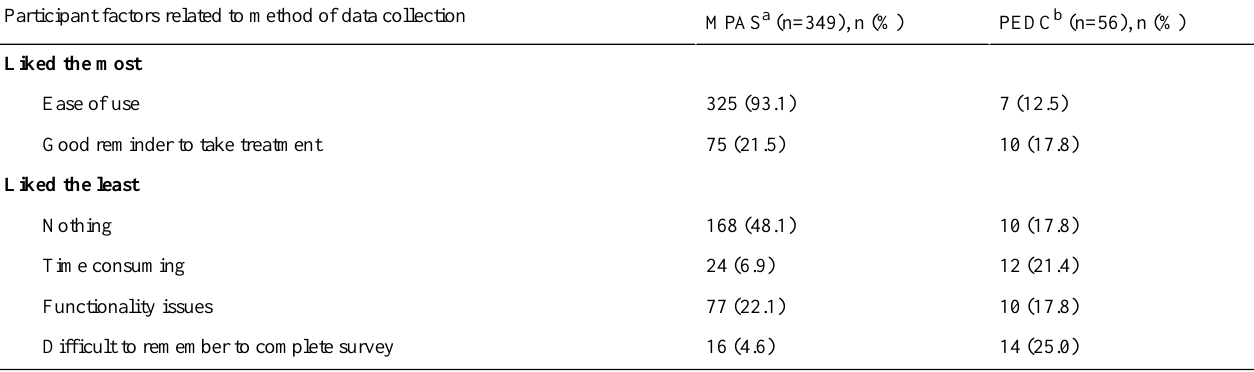
Table 3. Qualitative analyses of the likes and dislikes of mobile phone automated system users compared with paper and email data collection system